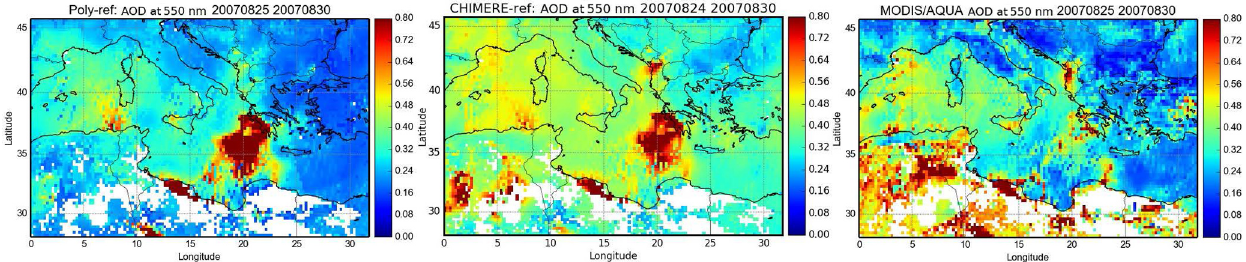
Figure D1. Mean total AOD (at 550nm) from MODIS/AQUA, Poly-ref and CHIMERE-ref during the second fire event (24–30 August